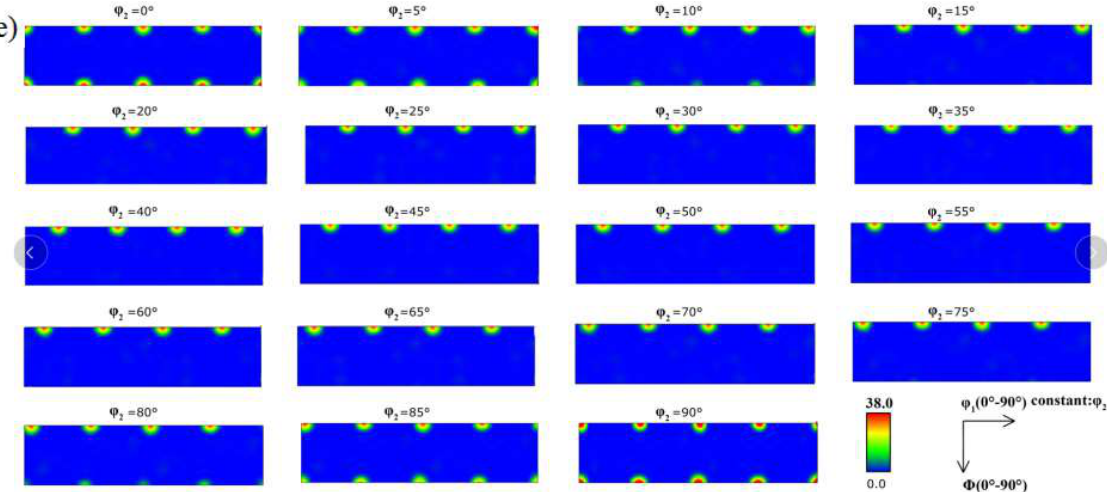
Figure 7. ODF diagram of the rolled and annealed copper foil. ( a ) Rolled sample; ( b ) 1 min; ( c ) 5 min; ( d ) 10 min; ( e ) 60 min.